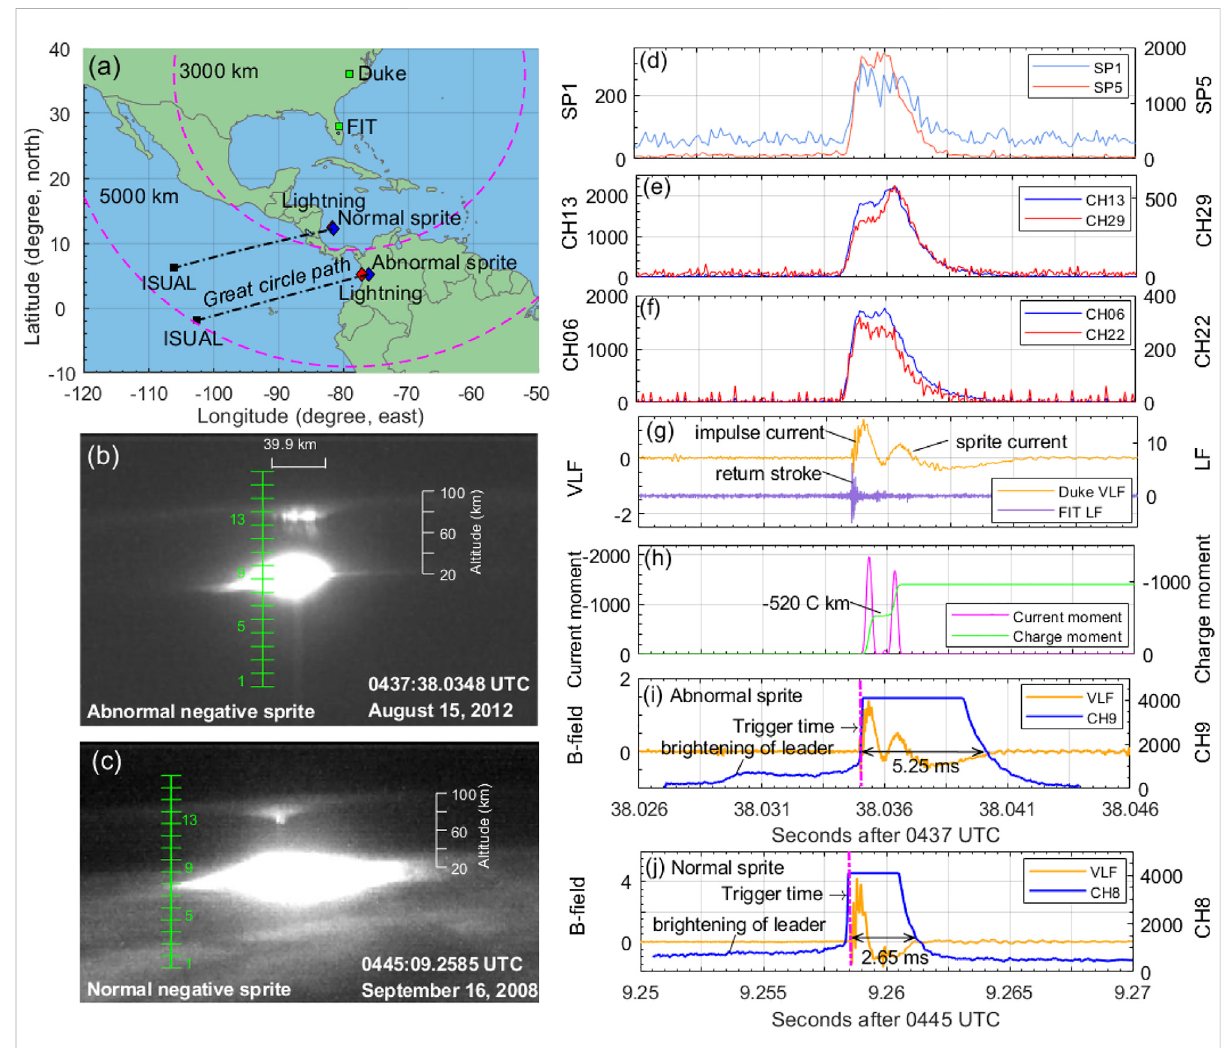
FIGURE 9 ISUAL observation of an unusual negative sprite for which the simultaneous measurement of VLF sferics also shows the signature of “ sprite current. ” . Panel (A) shows the ISUAL observations of two negative sprites, including one abnormal event [panel (B) ] demonstrating the sprite current feature shown in the very low-frequency (VLF) sferic signal recorded in Duke Forest [panel (G) ] and one normal event [panel (C) ]. The selected other ISUAL measurements for the abnormal event were plotted in panels (D – F) . The comparison between VLF signal and brightness curve is shown in panels (I,J) , respectively. Adapted from Wang et al.